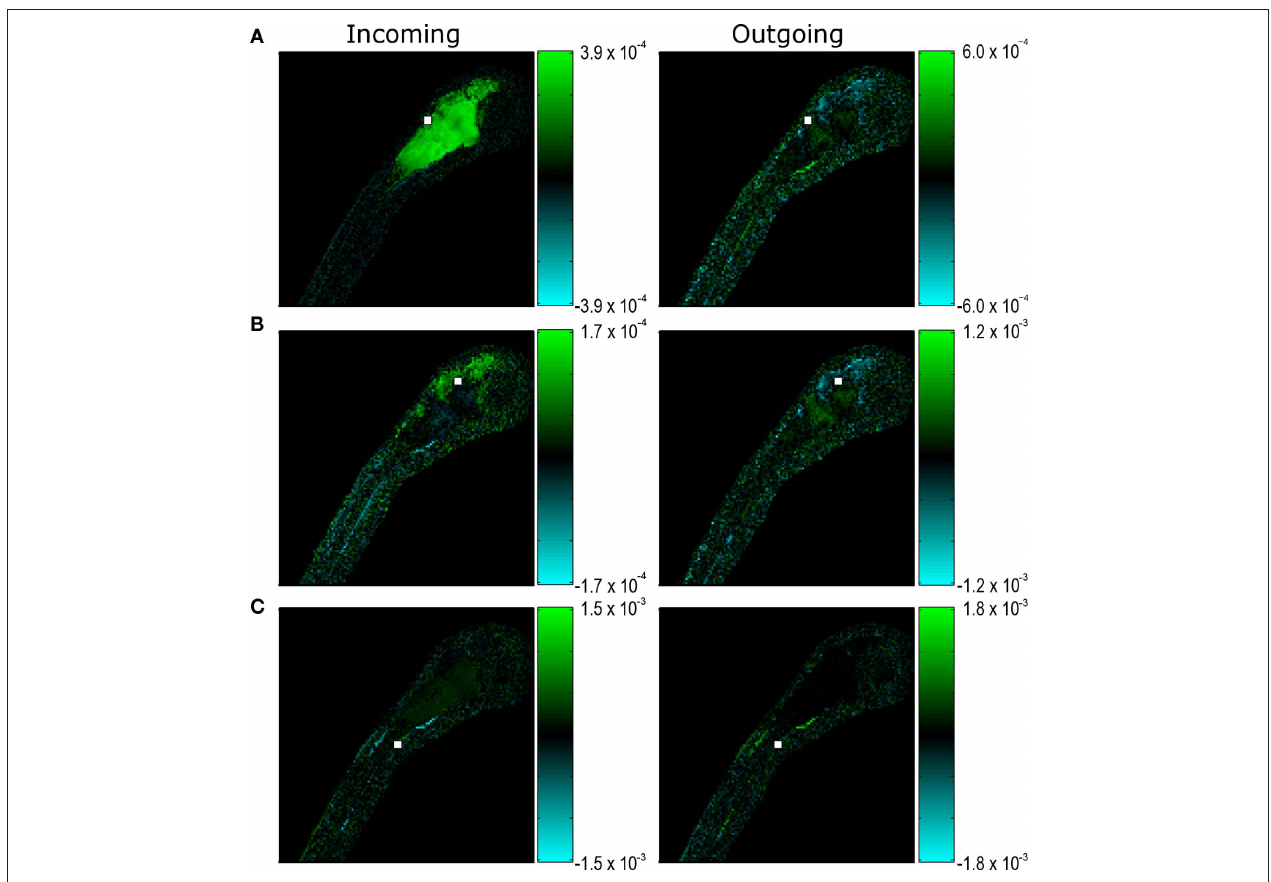
Figure 6 | Putative in- and out-going reduced connectivities for presumptive neurons (pixels) in the CNS of a 7 dpf larval zebrafish. Reduced connectivities estimated from an SVD decomposition have been visualized in the image basis (see text). Green (cyan) pixels represent putative